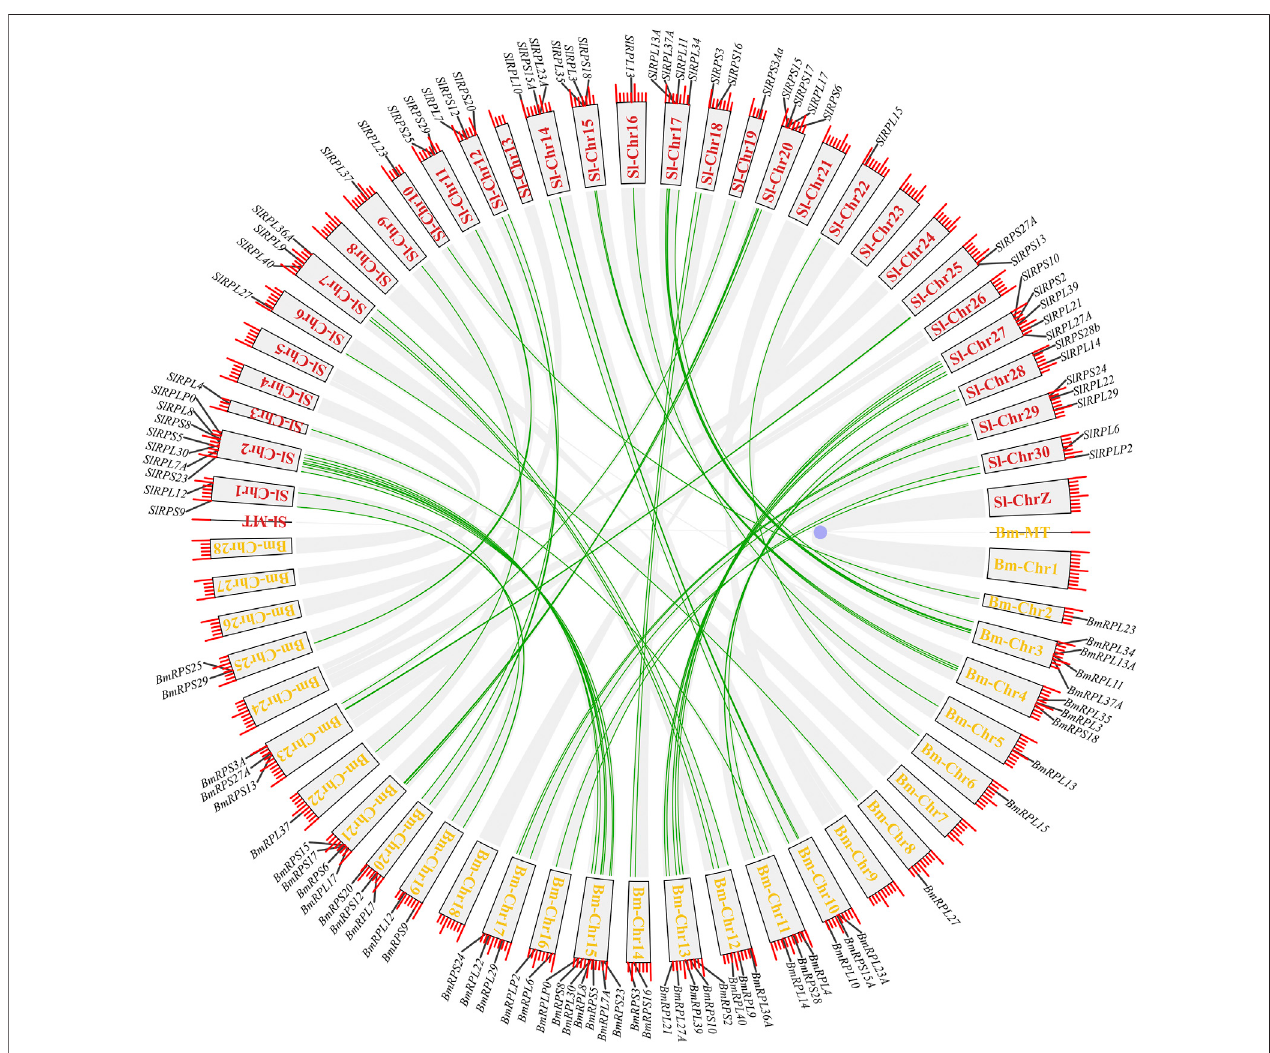
FIGURE 2 | Synteny analysis of Rp genes in S. litura and B. mori . The red and yellow fronts in the blocks represented the chromosome labels in S. litura ( Sl ) and B. mori ( Bm ), respectively, and the green lines refer to the orthologous Rp genes in S. litura and B. mori .